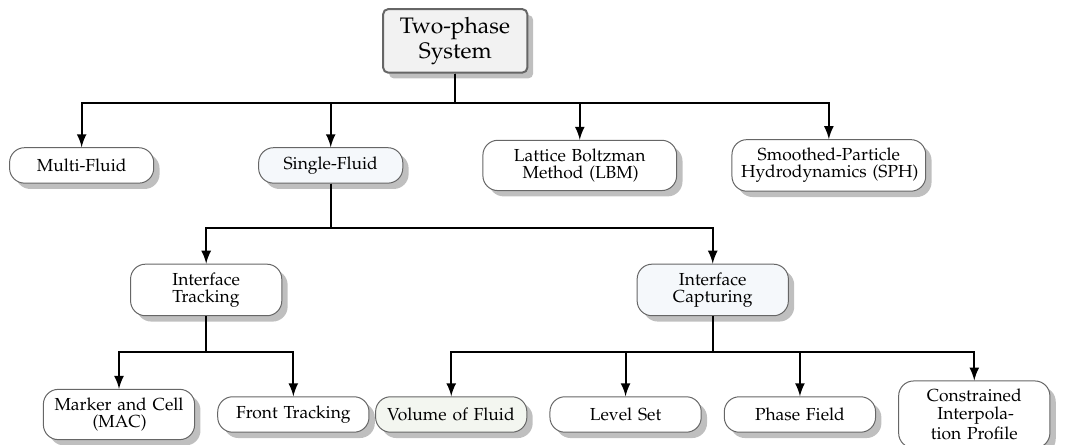
Figure 1. Available methods for the solution of two-phase problems. In this work, an algebraic-type VoF is applied to capture the